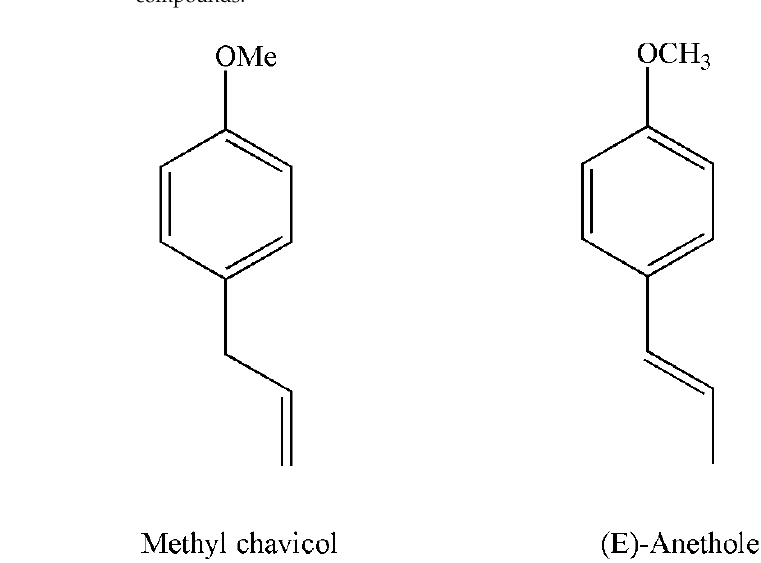
Figure 3. Structures of the most abundant components in wild fennel essential oil. Furthermore, p -Cymene (6.5%), α -phellandrene (5.9%), β -phellandrene (4.9%), and fenchone (3.2%) are components that are somewhat less represented. The components of essential oils in fennel leaves that are present in the range of 1% to 2% are α -thujene (1.9%), trans-piperitone epoxide (1.8%), δ -3-carene (1.7%), hexadecanoic acid (1.7%), γ -terpinene (1.4%), myrcene (1.3%), methyl o-anisate (1.3%), α -phellandrene epoxide (1.2%) and